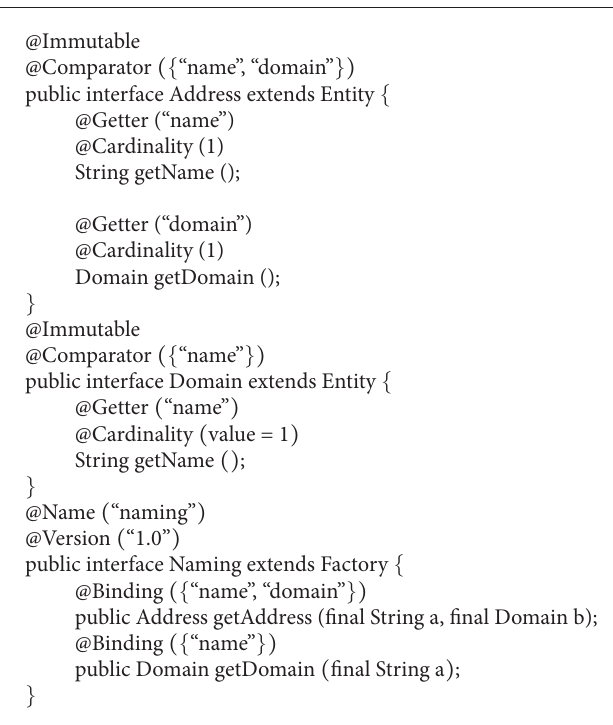
F 1: A simple naming domain